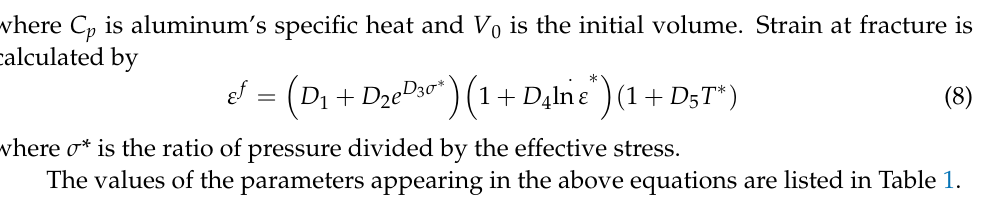
Table 1. Values of the parameters of Equations (2)–(5)